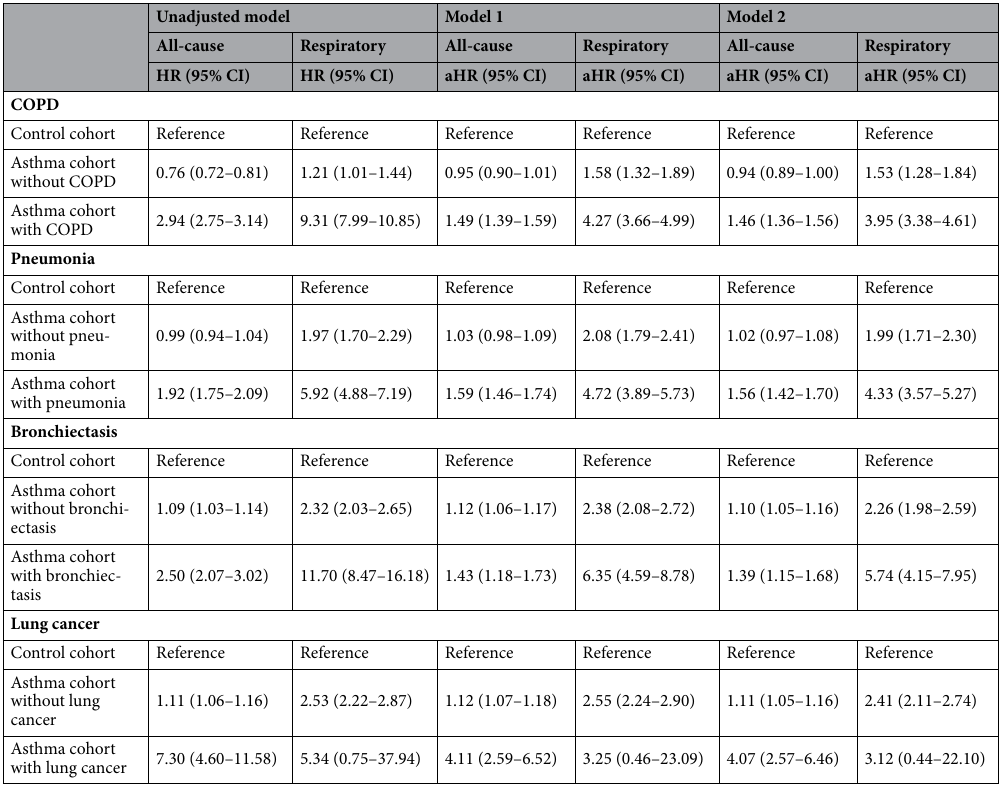
Table 2. The effects of asthma and its coexisting respiratory comorbidities on mortality in patients with asthma compared with subjects without asthma. Data are presented as a ratio (95% CI). Model 1: age and sex were adjusted; Model 2: age, sex, and type of insurance were adjusted. HR, hazard ratio; CI, confidence interval; aHR, adjusted HR; COPD, chronic obstructive pulmonary